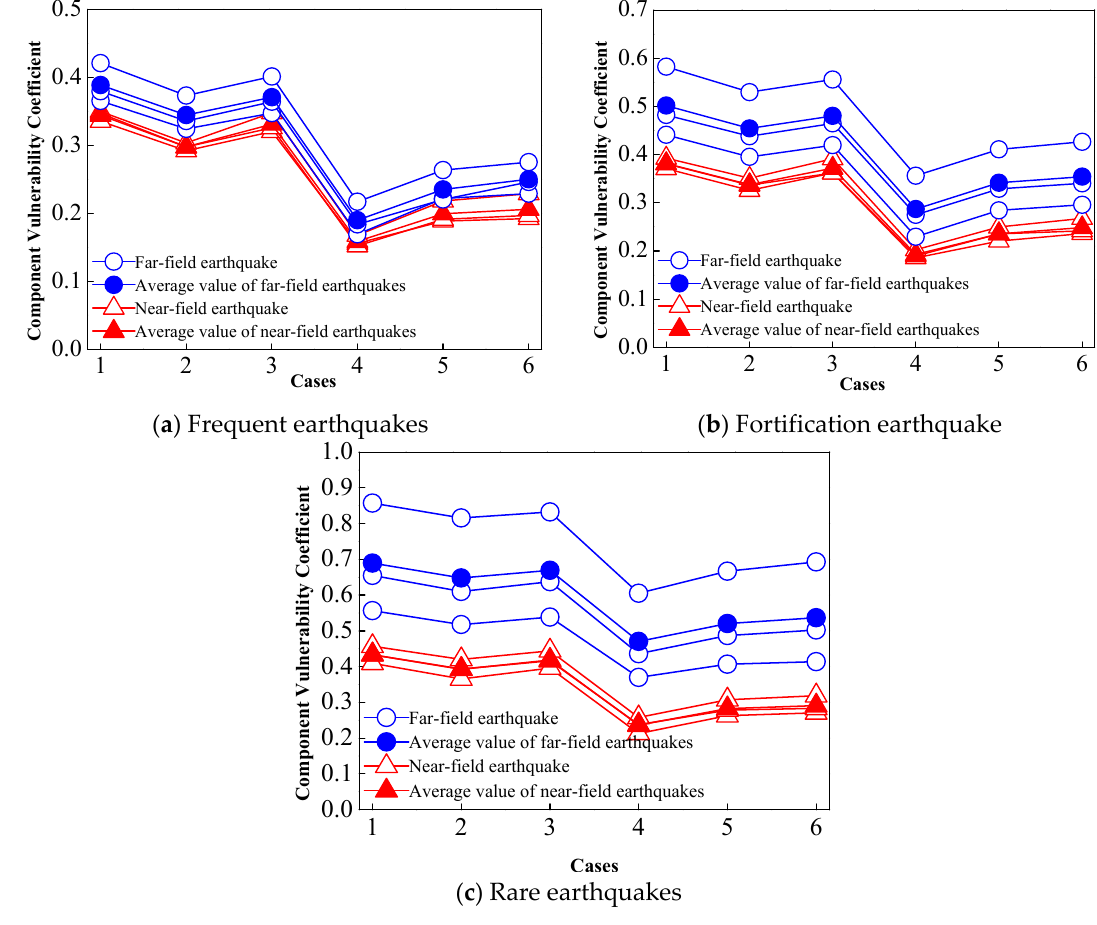
Figure 9. Component vulnerability coefficient curves of model A.